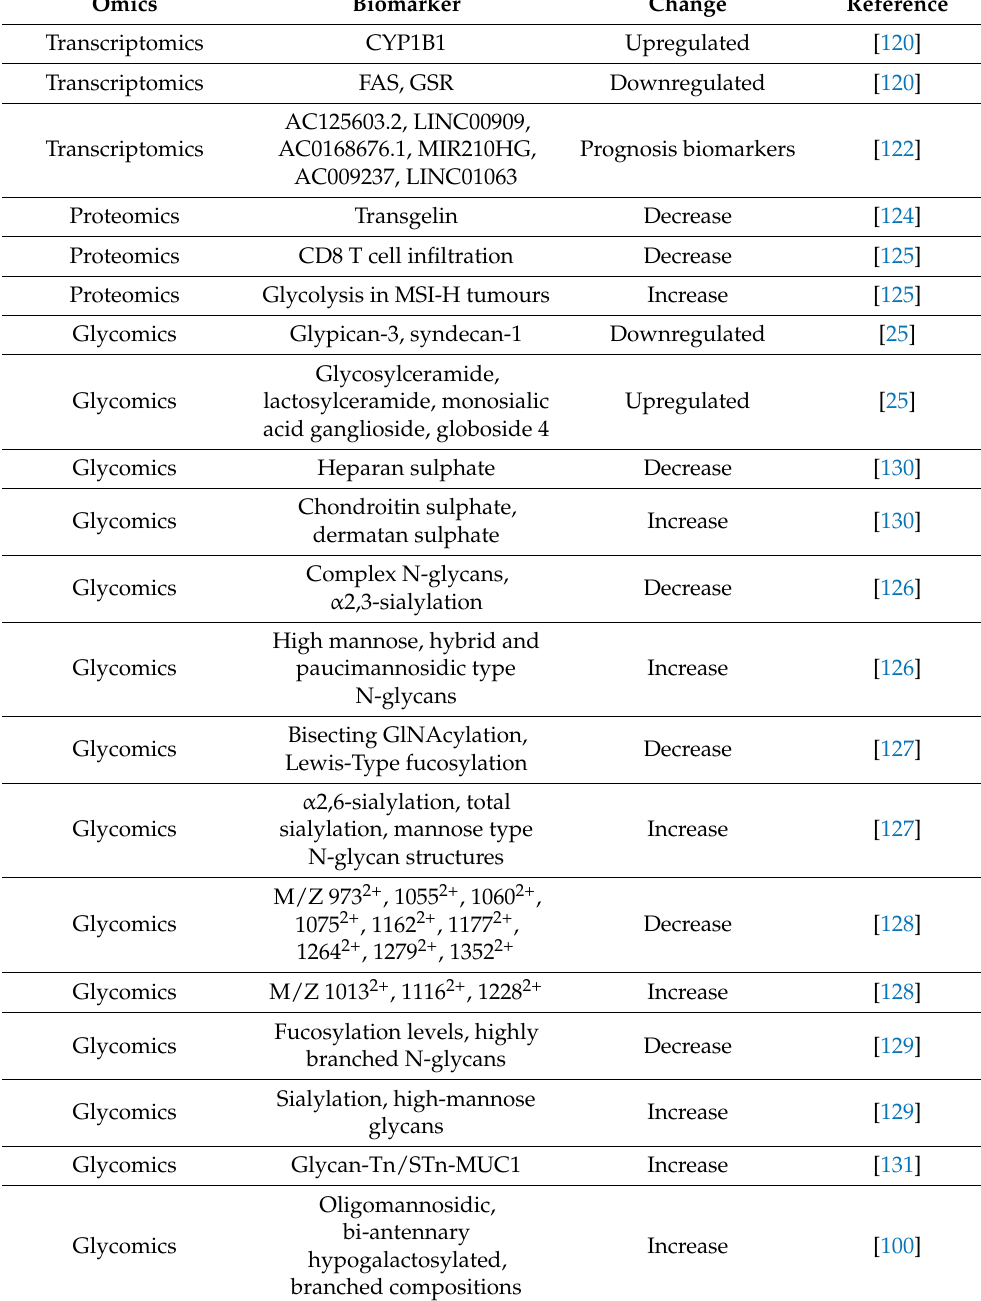
Table 6. Main biomarkers found in tissue samples of CRC patients with different omics